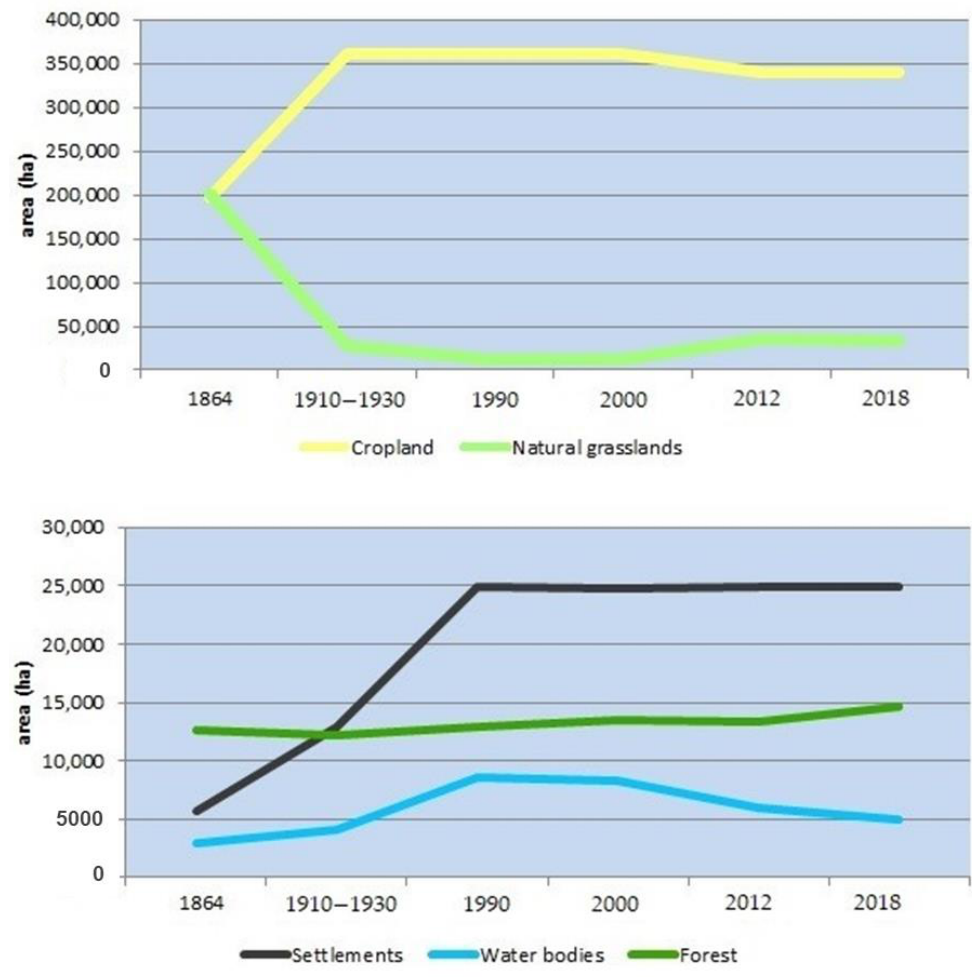
Figure 7. Land use dynamics in Central B ă r ă gan Plain